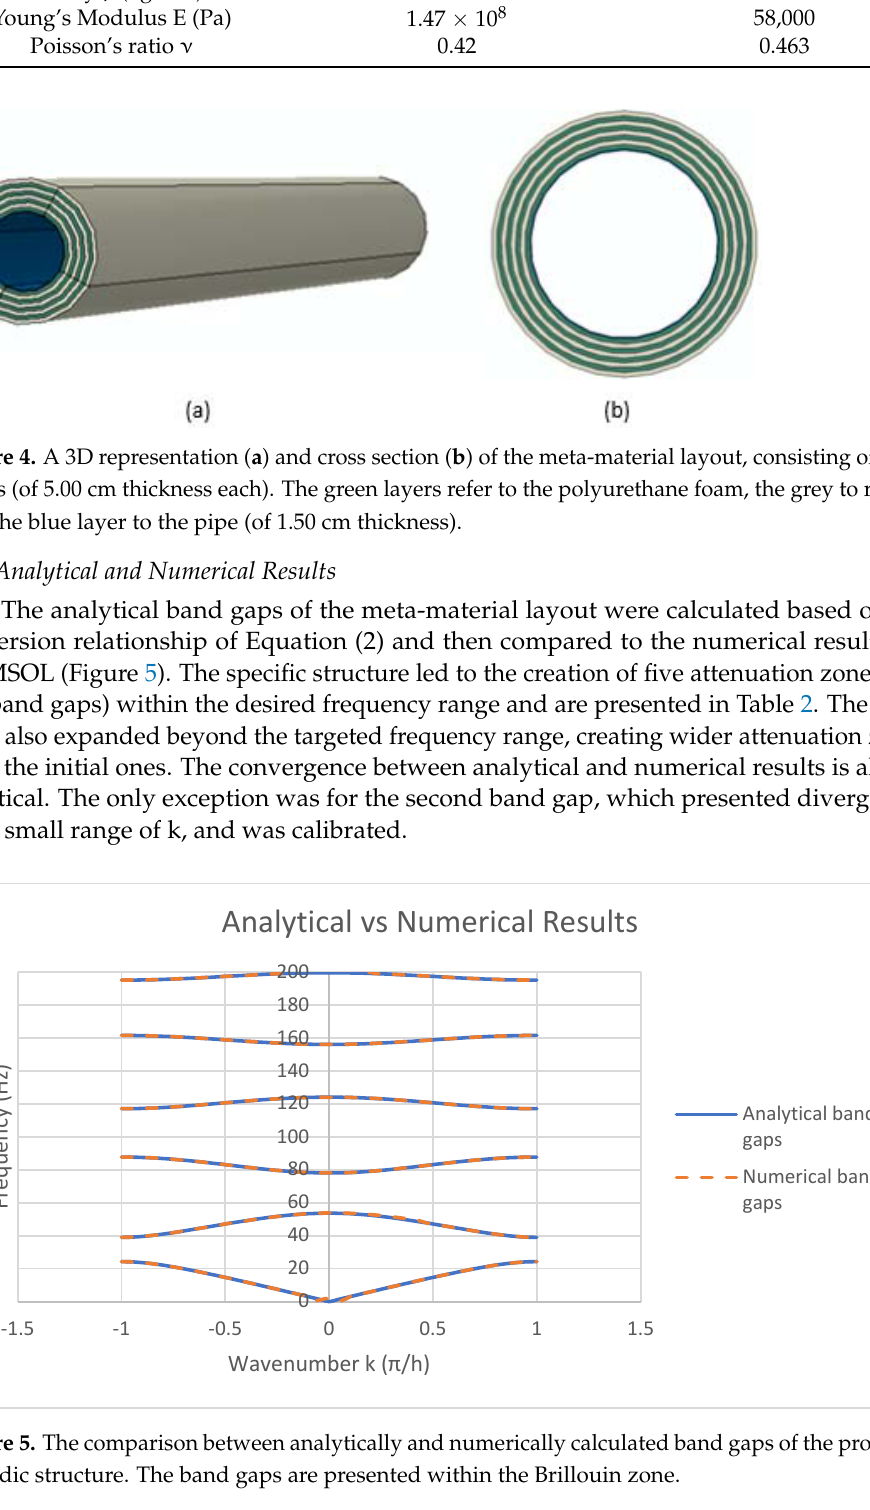
Figure 5. The comparison between analytically and numerically calculated band gaps of the proposed periodic structure. The band gaps are presented within the Brillouin zone.